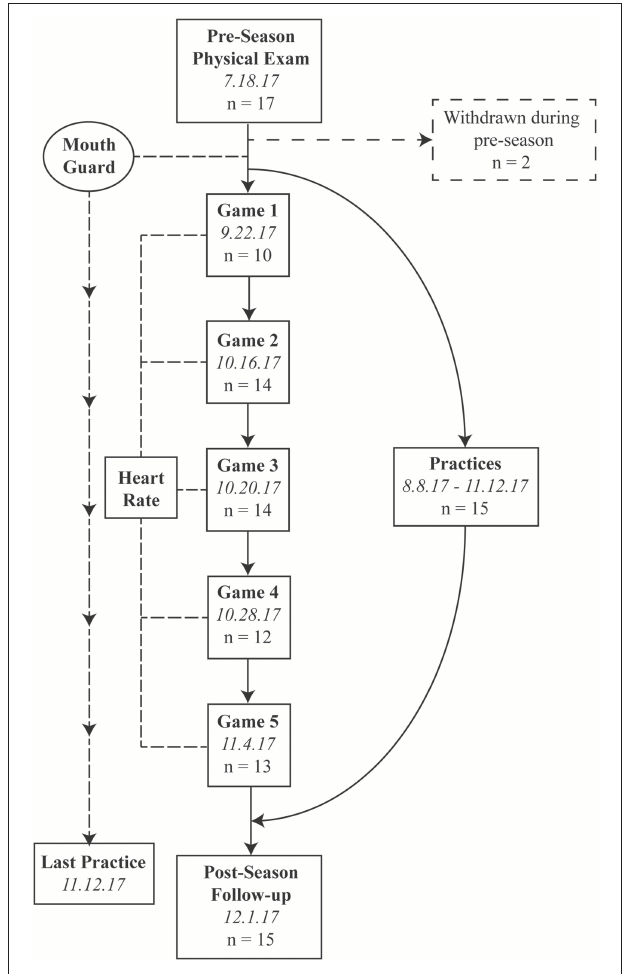
FIGURE 1 | Study flow